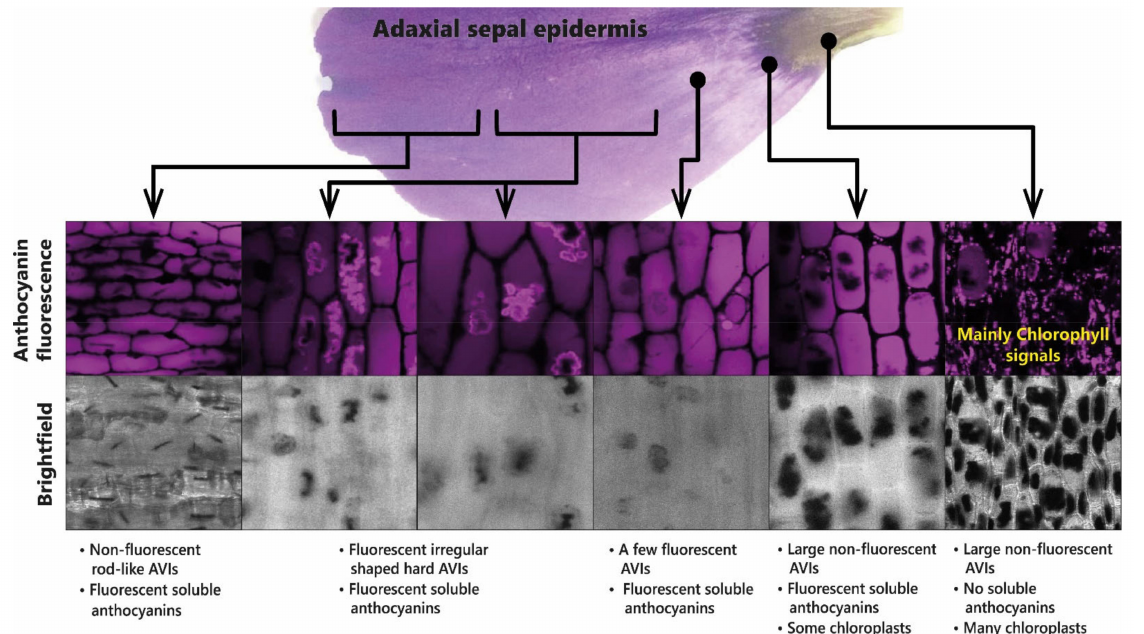
Figure 12. Presence of anthocyanin aggregates in the sepals of lisianthus is associated with the production of aggregates of acylated anthocyanins. The anthocyanic vacuolar inclusions (AVIs) that give the dark colour to the base of the sepals do not fluoresce under UV light. The soluble anthocyanins in lisianthus sepals fluoresce as do some additional anthocyanin aggregates from the outermost regions of the